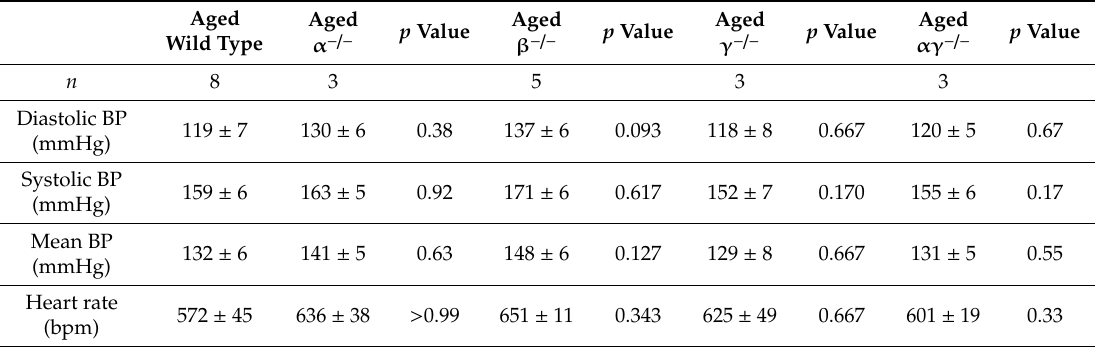
Table 3. Hemodynamic parameters measured using tail-cu ff plethysmograph in conscious aged single synuclein-null ( α − / − , β − / − , γ − / − ) and the double synuclein-null ( αγ − / − ) animals. Means ± S.E.M were compared with Mann–Whitney U rank test.